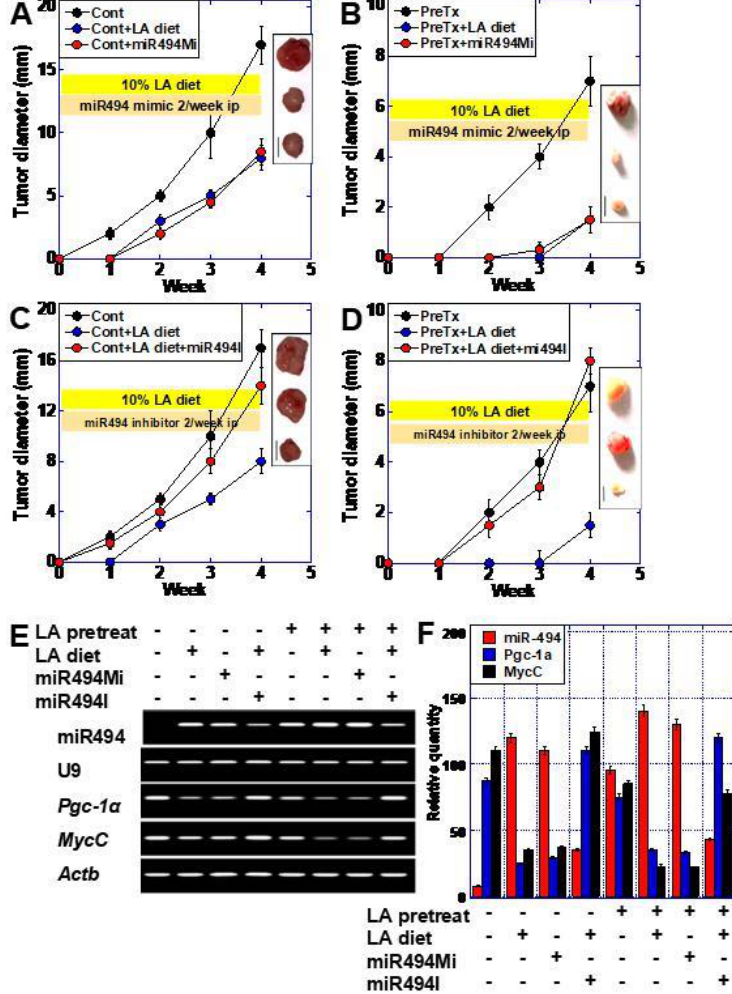
Figure 4. miR-494 mediated LA-induced growth impairment in a mouse model. ( A , C ) Effect of miR-494 mimic (miR-494Mi) or miR-494 inhibitor (miR-494I) on LA-induced growth inhibition. CT26 cells (1 × 10 7 ) were subcutaneously inoculated into BALB/c mice, which were fed a control or 10% LA diet. (Insert) Example image of excised tumors. Cont, Cont+LA, Cont+Mi or I, from the top. ( B , D ) Effect of miR-494 mimic (miR-494Mi) or miR-494 inhibitor (miR-494I) on LA-induced growth delay. LA-pretreated (100 μg/mL for 48 h) CT26 cells (1 × 10 7 ) were subcutaneously inoculated into BALB/c mice, which were fed a control or 10% LA diet. (Insert) Example images of excised tumors. PreTx, PreTX+Mi or I, PreTx+LA, from the top. ( E ) Expression of miR-494, Pgc-1 α , and MycC in each experimental group at week 4. U9 and Actb expression were analyzed as loading controls. miR-494 mimic and miR-494 inhibitor were administered at a dosage of 7 mg/kg body weight intraperitoneally twice per week. ( F ) Expression of miR-494, Pgc-1 α , and MycC in each experimental group at week 4 examined by quantitative RT-PCR. Error bar, standard deviations of data from 5 mice. Scale bar, 5 mm. LA, linoleic acid; PGC, peroxisome proliferator-activated receptor gamma coactivator; ACTB, actin β